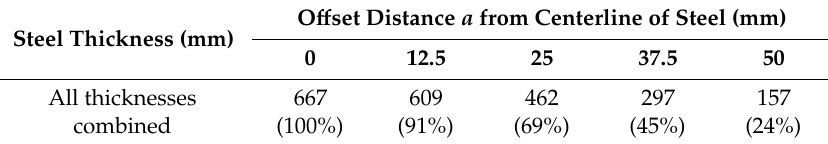
Table 3. ∆ V (m / s) for height variation at t = 20 mm and d = 75 mm.